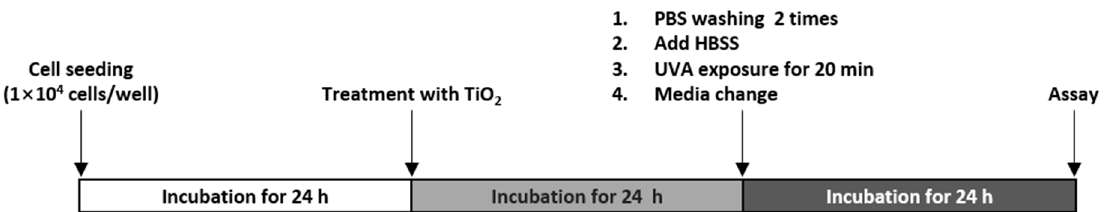
Figure 1. Outline of the experimental procedure.